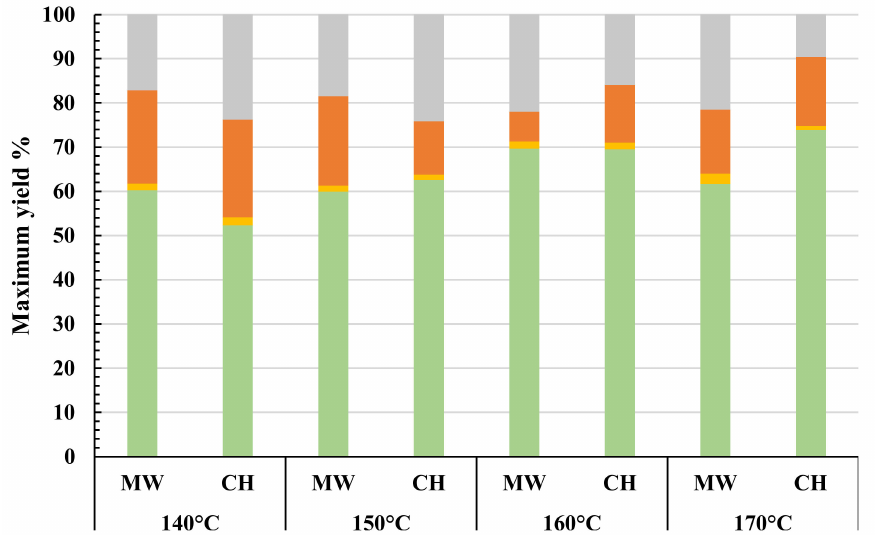
Figure 7. Temperature effect on the simulated maximum 5-HMF yield using MW heating for 10 min and CH for 90 min. The parameter estimates in the model correspond to the following condi- tions: 3 mL DMSO/acetone medium (70:30 w / w ), 10 mg MIL-101(Cr)-SO 3 H(3), and 100 mg fructose (0.56 mmol). ( (cid:4) ) represents 5-HMF yield %, ( (cid:4) ) represents FA + LA yield %, ( (cid:4) ) represents interme- diate yield %, and ( (cid:4) ) represents side product yield